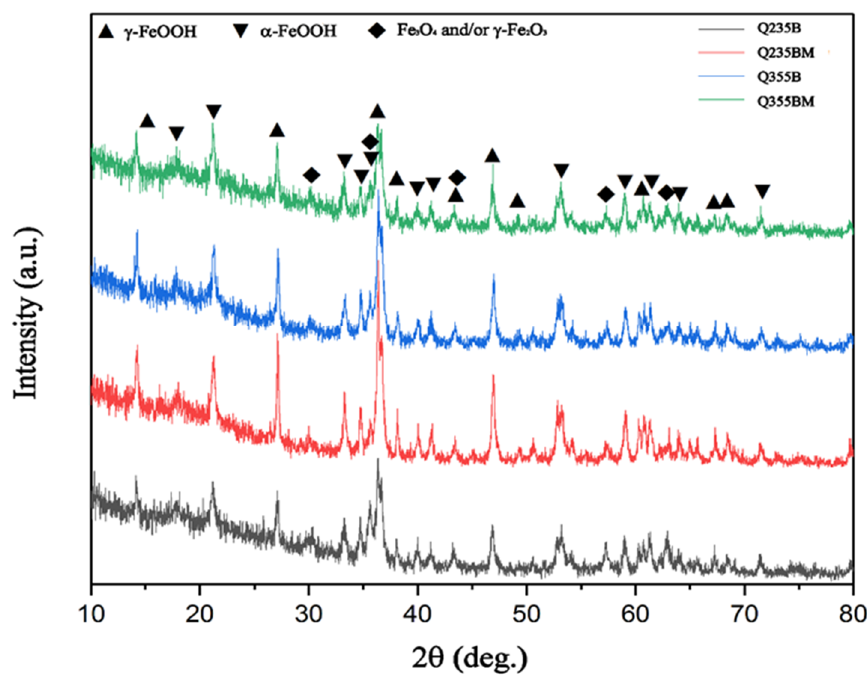
Figure 4. XRD analysis of corrosion products. Table 2. The relative content of corrosion products of steel samples.